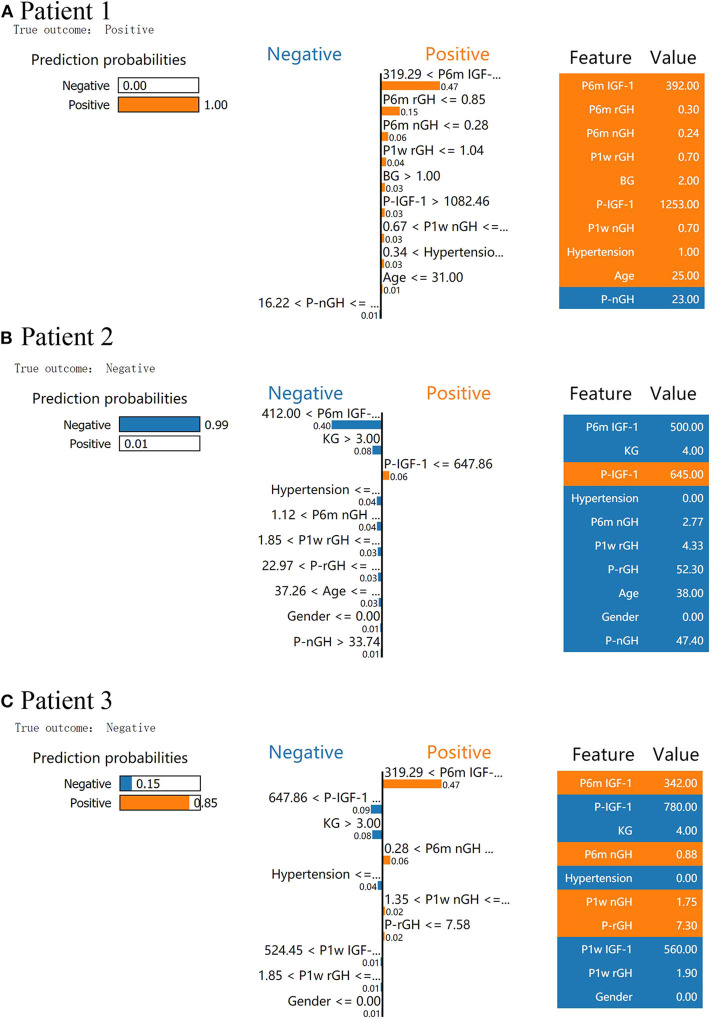
Results of local interpretable model–agnostic explanation (LIME) with XGBoost classifiers applied to two correctly predicted patients [one negative (non-delayed remission) and one positive (delayed remission) patient)] and one incorrectly predicted patient (non-delayed remission patient, incorrectly predicted with high probabilities of delayed remission). The figure reveals the role of various features in the incidence of delayed remission in each patient. The first column represents the prediction probabilities of negative and positive results achieved from the classifiers. The second column shows the contributions made by the features included in the models to the probability. The third column displays the original data values of these features. (A) LIME explanation for patient 1 as true positive, (B) LIME explanation for patient 2 as true negative, and (C) LIME explanation for patient 3 as false positive.